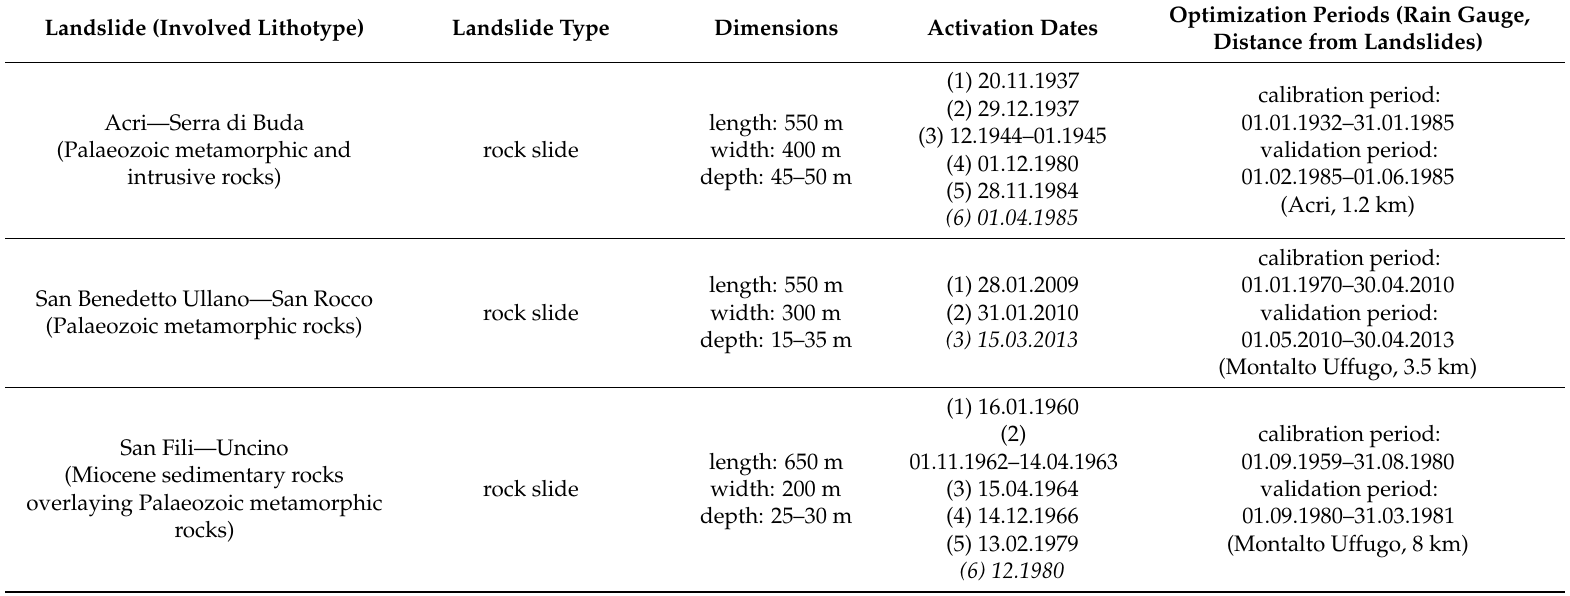
Table 2. Main characteristics of the Calabrian case studies. In Italics, the dates of activation used for validation. Employed data series range from the beginning of the calibration periods to the end of the validation period (cf. last column). No missing data characterize the considered rain